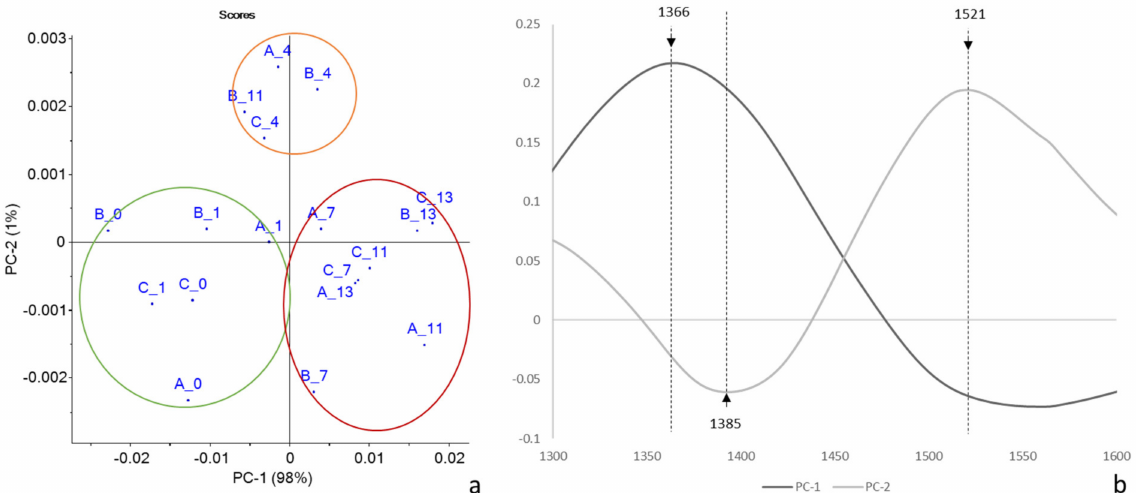
Figure 9. PCA score ( a ) and loading ( b ) plots of pre-treated NIR spectra of rocket salads of Trial 2 (each point corresponded to the mean spectra for each